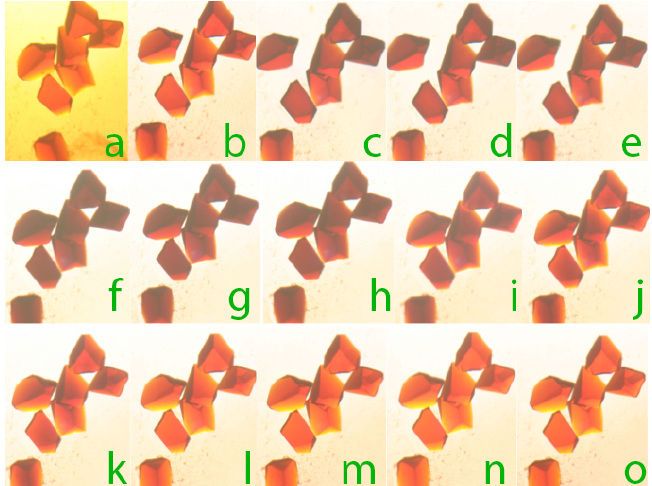
Figure 6. Crystals of satellite tobacco mosaic virus (STMV) were saturated with the dye m-cresol purple at pH 5.5 and appear as in ( a ). The mother liquor was replaced with equivalent mother liquor at pH 8.0 and the crystals changed color to dark red in ( b ) through ( h ). When the original pH was restored in the mother liquor, the crystals ( i ) through ( o ) reverted to the initial color. This experiment, repeated with numerous other protein crystals demonstrates the reversible nature of the color changes and that crystals can experience multiple cycles of pH induced transitions. The series of images ( a – o ), taken at appropriate time intervals, shows the progress of the dye.